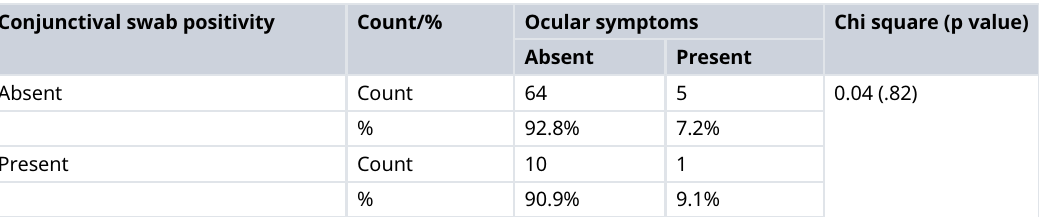
Table 4. Conjunctival swab positivity * Ocular symptoms.